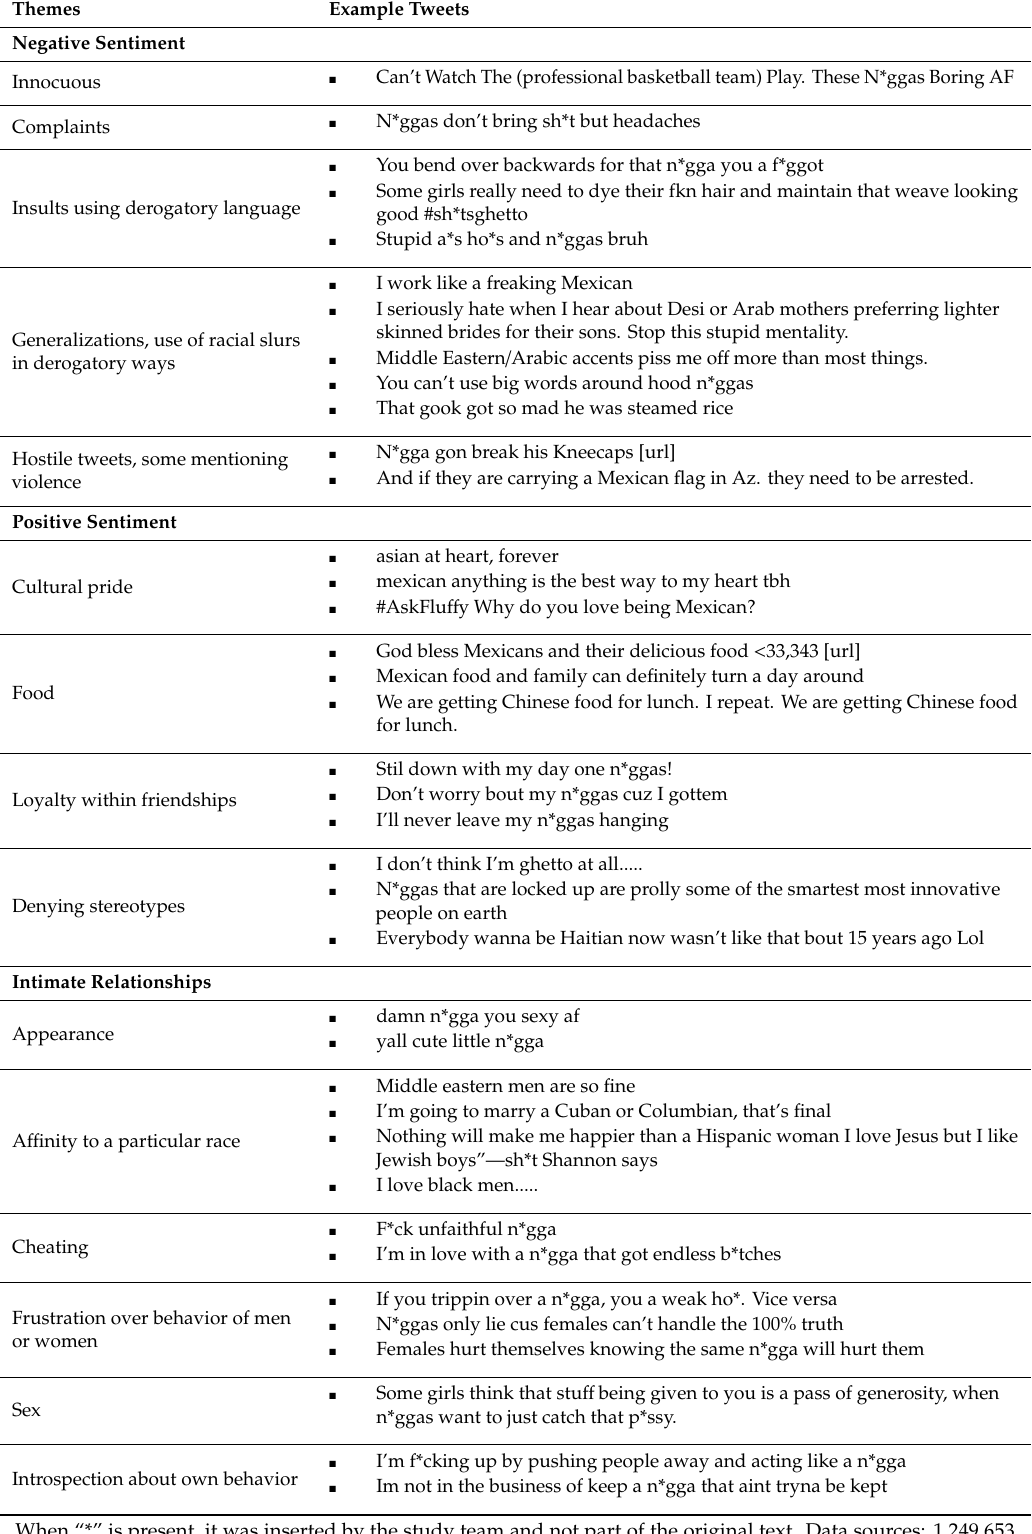
Table 2. Content analysis themes of 2015–2016 US tweets with illustrative Examples,